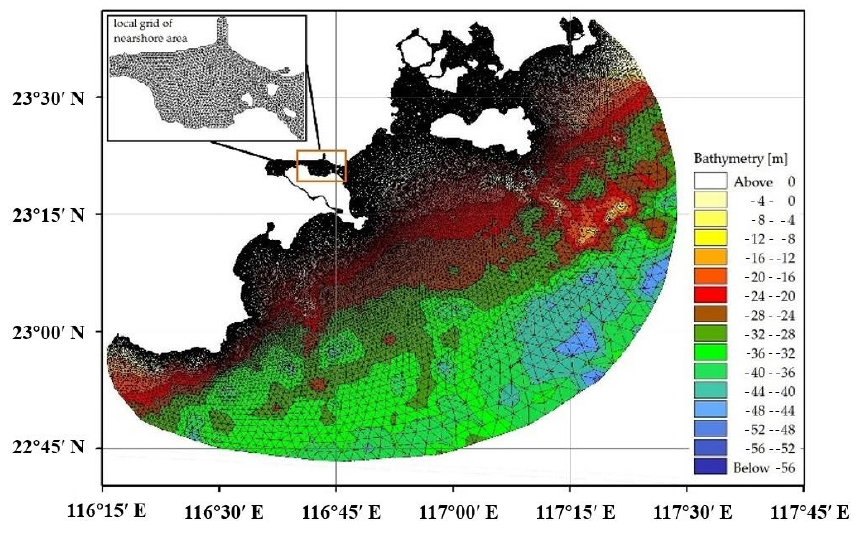
Figure 2. Grid division diagram of the study area.